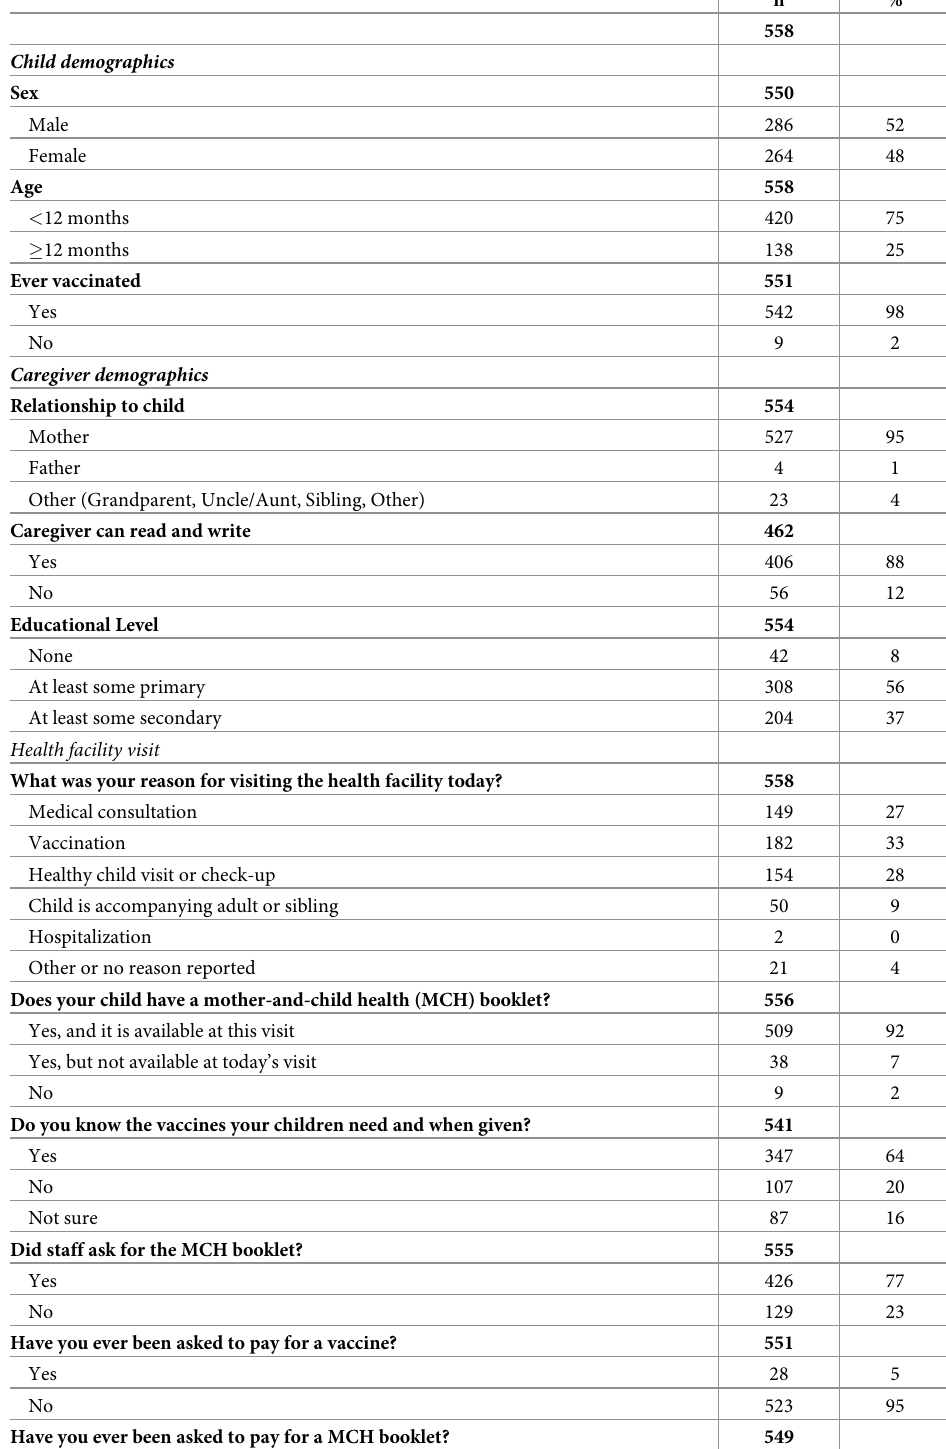
Table 2. Characteristics of surveyed caregivers of children with documented vaccination dates, missed opportuni- ties for vaccination (MOV) assessment, Kenya,